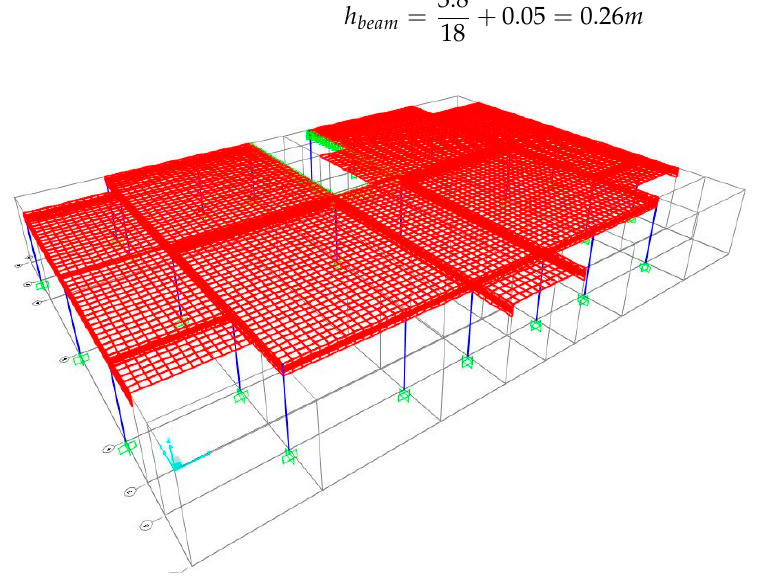
Figure 28. Finite element mesh of the first case of study. Table 4. Data to calculate beam height to verify indirect deformation, according to EC2.